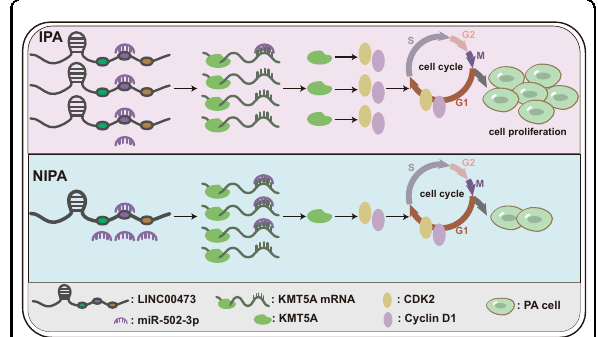
Fig. 7 Hypothesis diagram of the role and mechanism of LINC00473/miR-502-3p/KMT5A axis in IPA. The overexpression of LINC00473 in IPA upregulates KMT5A by inhibiting miR-502-3p, thereby upregulating the expression of cyclin D1 and CDK2, facilitating cell cycle progression and promoting cell